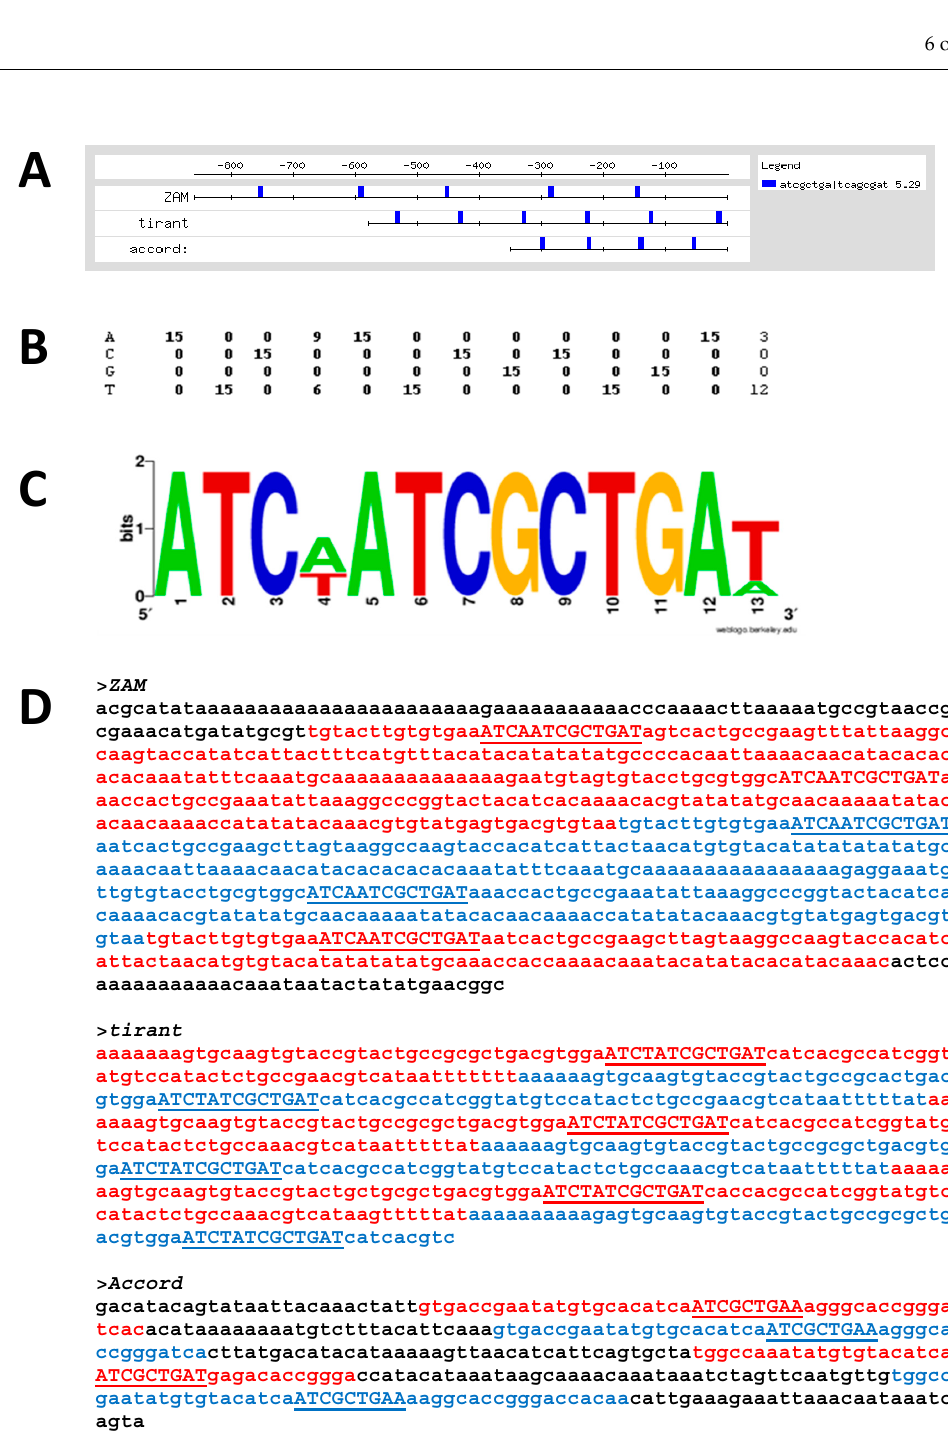
Figure 2. Bioinformatics analysis of the 5 ′ -UTRs of ZAM , Tirant , and Accord. ( A ) Feature map of over-represented TERM in the 5-UTRs of the indicated RTs. The scale bar provides coordinates relative to the first ORF (GAG) start of the retrotransposons. Note the regularity of the TERM motif in the 5 ′ -UTRs; ( B ) display of the logos of the TERM motif. The graphic representation was created using WebLogo. Sequence logos are a graphical representation of an alignment of multiple nucleic acid sequences (PWM) developed by Tom Schneider and Mike Stephens [34] . Each logo is made up of stacks of symbols, one stack for each position in the sequence. The overall height of the stack indicates the conservation of the sequence at that location, while the height of the symbols within the stack indicates the relative frequency of each nucleic acid at that location; ( C ) positional weight Matrix of TERM motif; ( D ) sequence of the tandem repeats present in the 5 ′ -UTR of the RTEs under examination. The single tandem repeats are in blue and red, while the TERM motifs are in uppercase underscored.